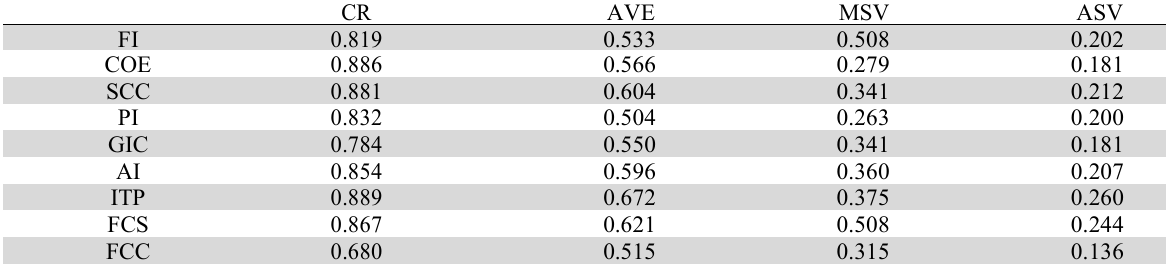
Convergent and discriminant validity (GIC28, GIC29 deleted) CR AVE MSV ASV FI 0.819 0.533 COE 0.886